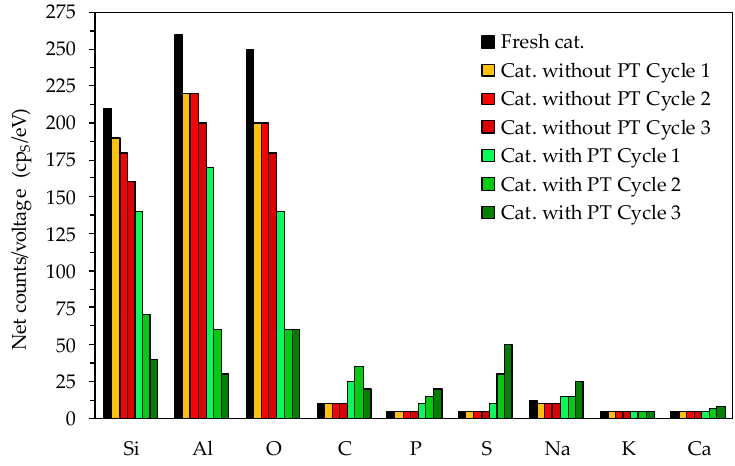
Figure 5. EDS of the spent catalysts after the pyrolysis experiments.